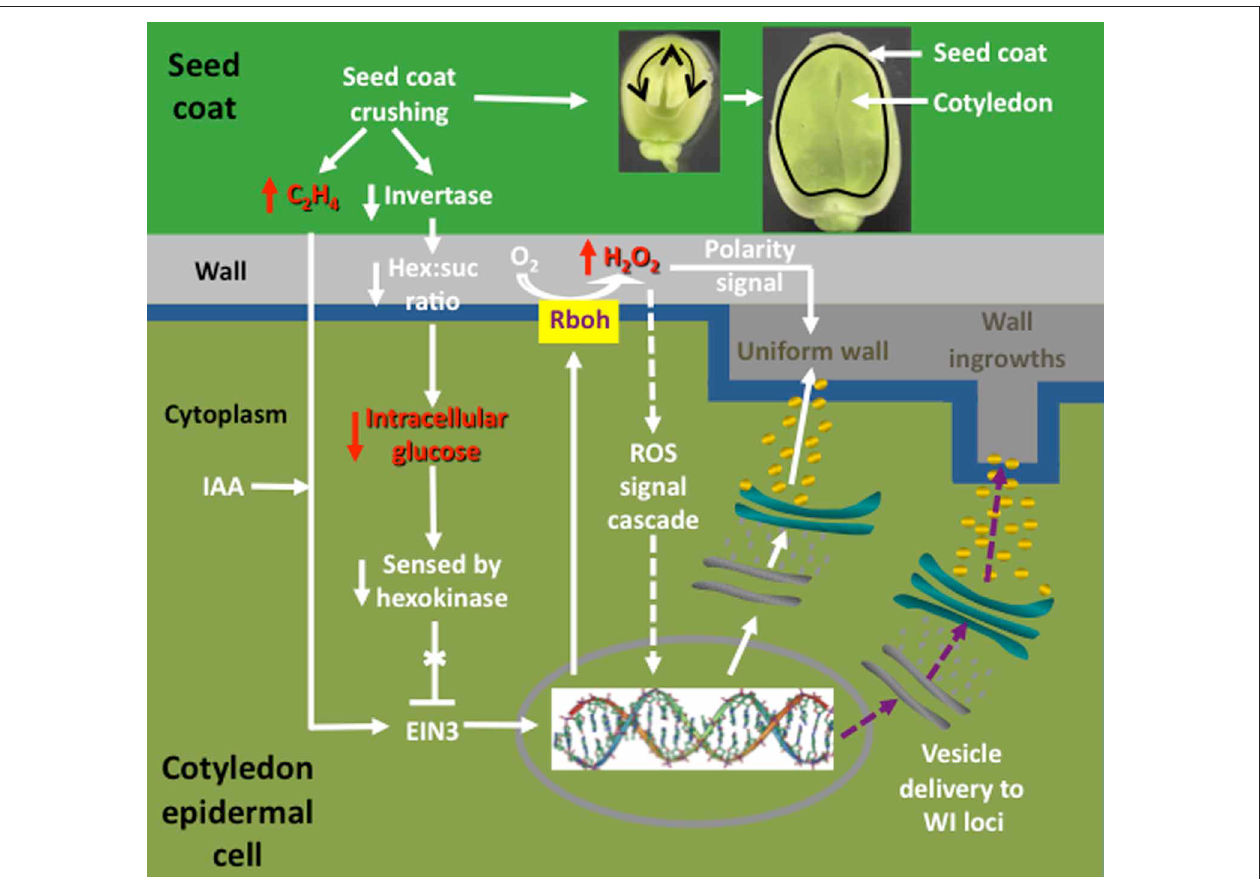
FIGURE 4 | Interrelationships between signals and signal cascades leading to induction, organization, and construction of polarized ingrowth walls in epidermal transfer cells of Vicia faba cotyledons. In cultured cotyledons, a combination of declining intracellular glucose levels and an auxin (IAA) regulated burst in ethylene production, initiates ingrowth wall formation within adaxial epidermal cells. The glucose/ethylene sequence is reproduced in planta and downstream events are deduced from findings obtained using cultured cotyledons. Prior to the onset of cotyledon growth, an extracellular invertase, localized to inner cells of the seed coat (dark green), hydrolyzes sucrose and the glucose product, sensed by a cotyledon epidermal cell (light green) hexokinase, blocks an ethylene signal cascade by down regulating ethylene insensitive 3 (EIN3), a key ethylene signal cascade transcription factor. Upon initiating expansion growth, the cotyledons crush inner cells of the seed coat (see images of seeds cut through their longitudinal plan illustrating cotyledon growth at two stages). Cell crushing